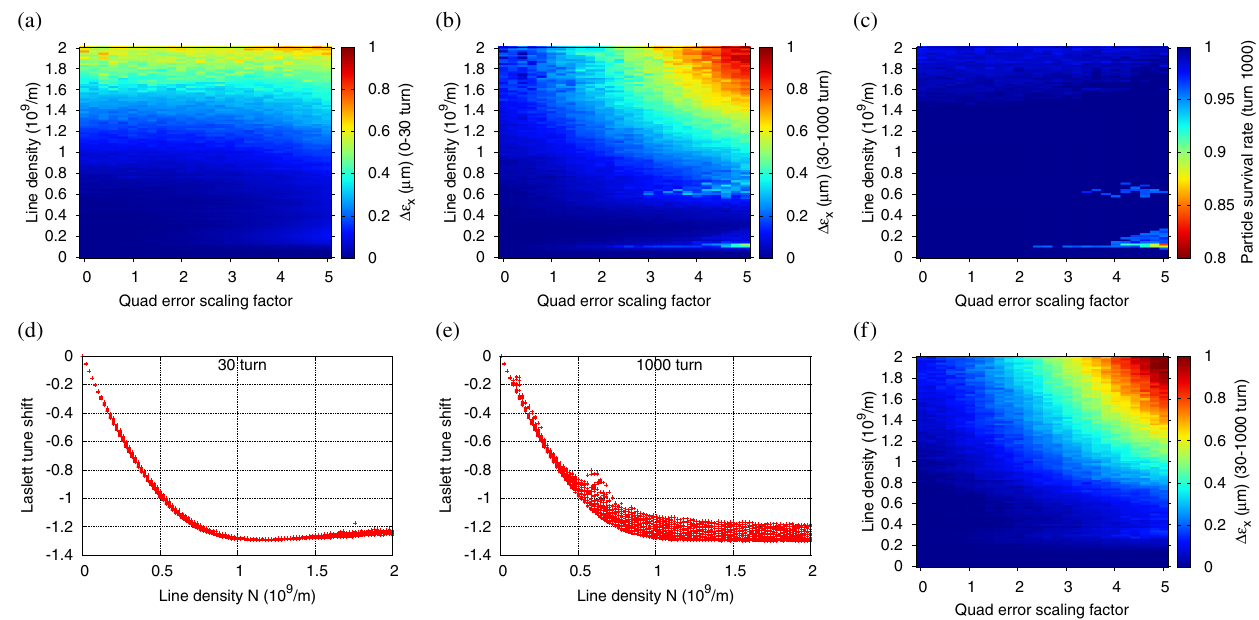
FIG. 6. Fixing ( ν x ¼ 2 . 6 , ν z ¼ 2 . 9 ), the emittance change of (a) turn 0 to 30 and (b) turn 30 to 1000. (c) Particle loss at turn 1000. Tune shifts vs different intensities with quadrupole scaling factors at (d) turn 30 and (e) turn 1000. (f) Emittance change of turn 30 to 1000 ( ν x ¼ 2 . 8 , ν z ¼ 2 . 9